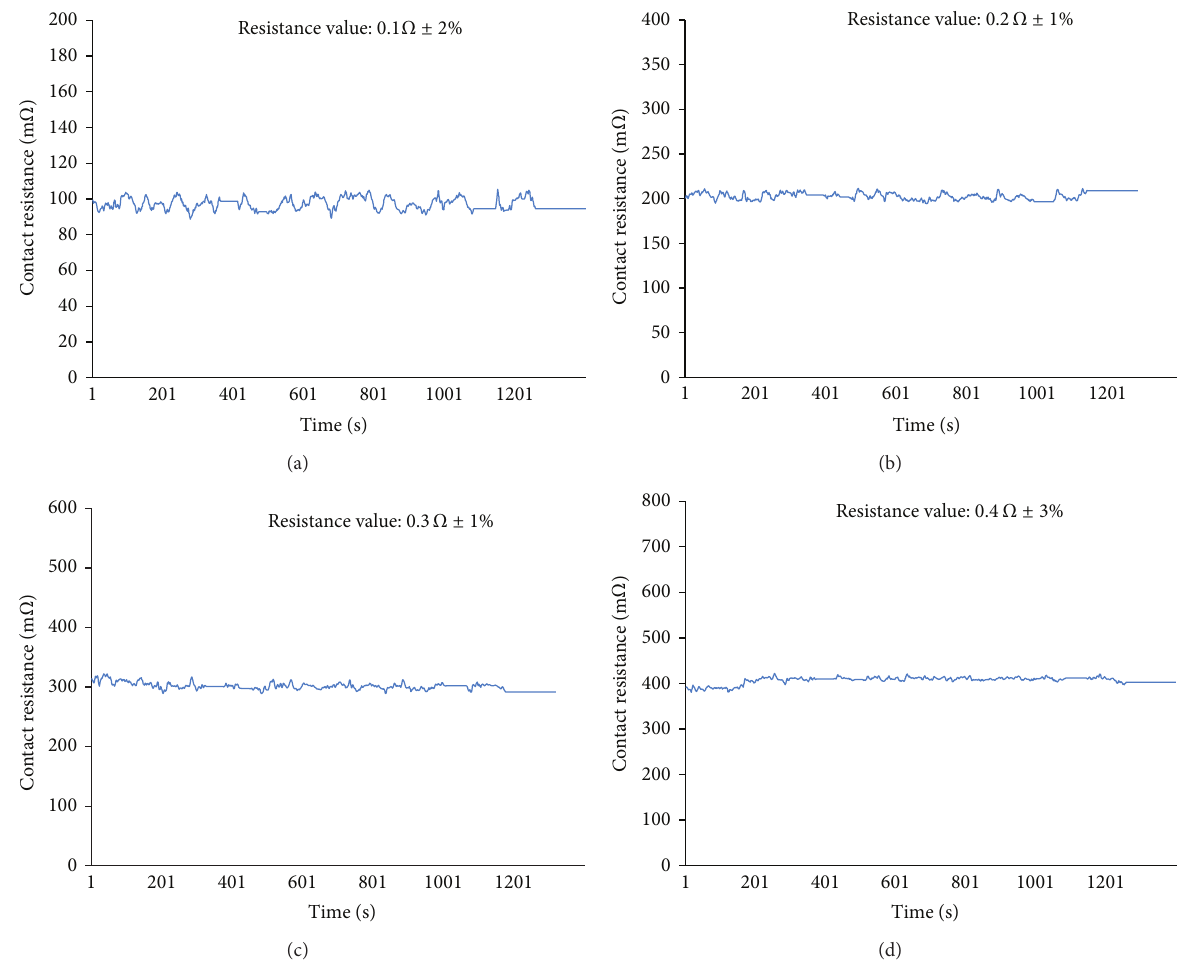
Figure 18: Contact resistance model and calculation algorithm verification. Table 1: Static insulation resistance test result.